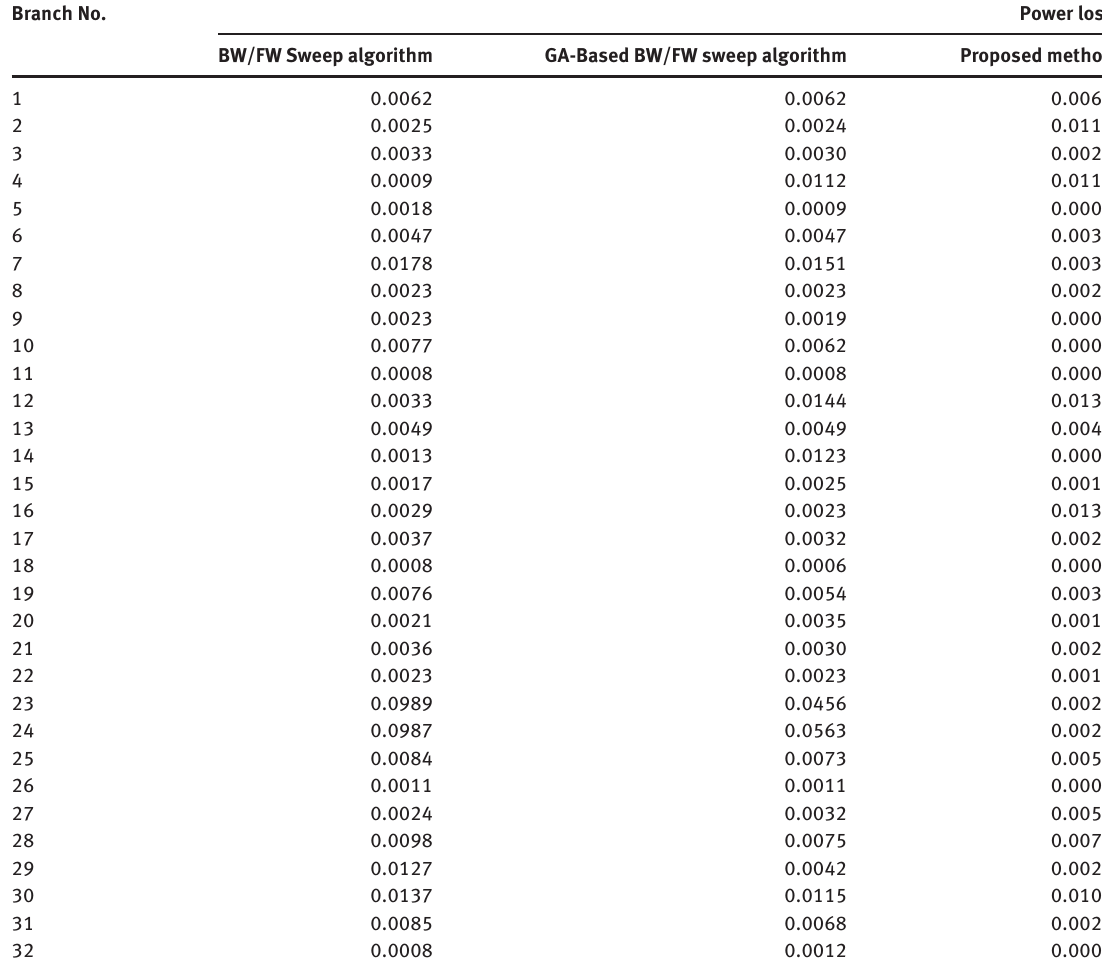
Table 3: Power Losses of the Distribution System. Branch